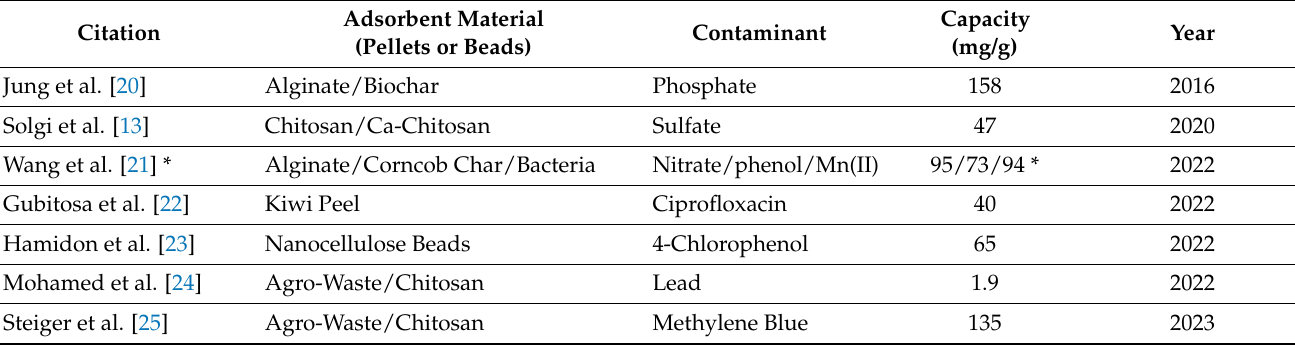
Table 1. Non-powdered adsorbents derived from agro-waste sources for contaminant